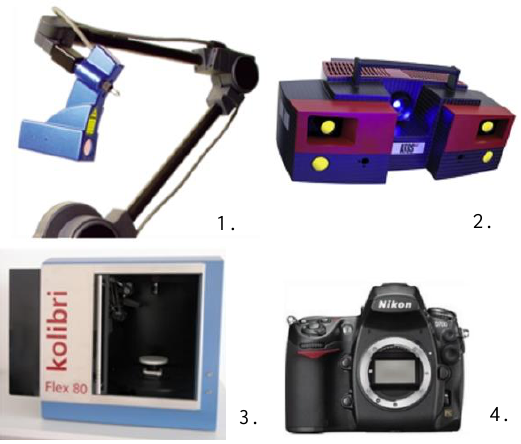
Figure 3. Systems used for the acquisition of point clouds